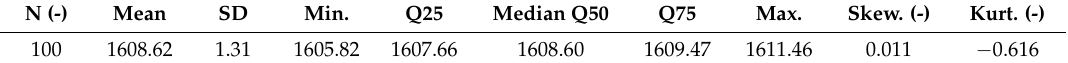
Table 1. Descriptive statistics of the annual energy consumption values. Unit: TJ/year if not otherwise stated in parentheses.